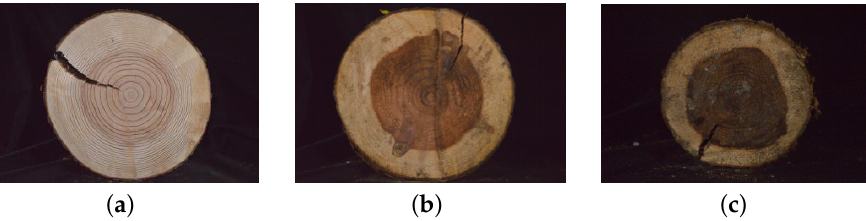
Figure 8. The indoor wood images. ( a ) An image of a processed log. ( b ) An image of an unprocessed low-noise log. ( c ) An image of an unprocessed high-noise log.